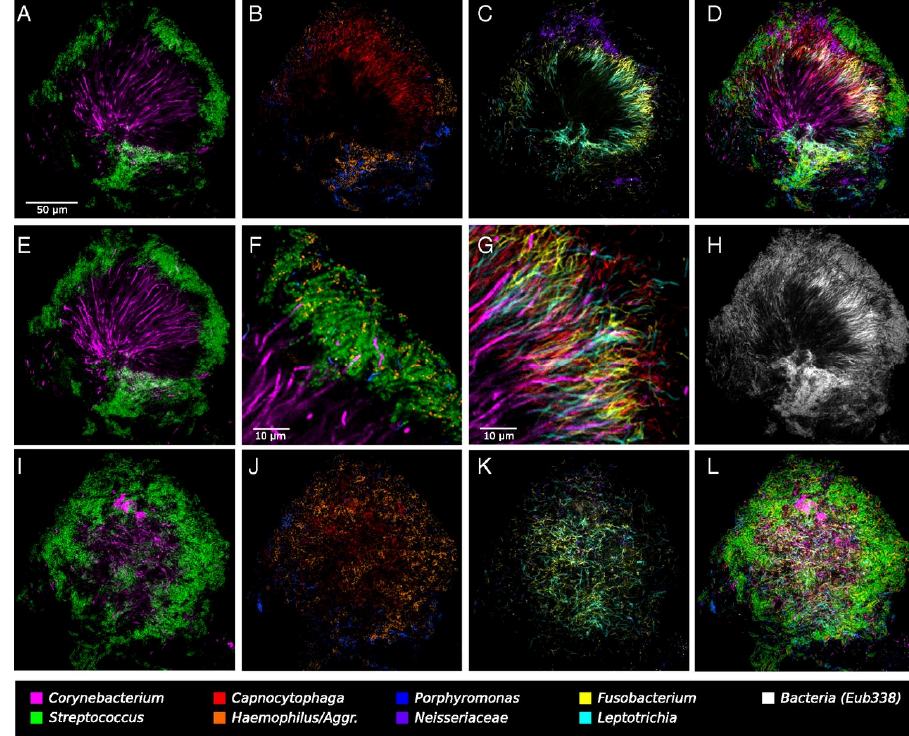
Figure 5. Hedgehog-shape structure. ( A – D , F – H ) represents a single focal plane nearby the middle part of the structure. ( A ) Corynebacterium sp. filaments radiating outward from near the center of the image and coccoid Streptococcus sp. cells arranged around the distal tips of the Corynebacterium sp. filaments. ( B ) Cells of Haemophilus/Aggregatibacter sp. and Porphyromonas sp. sited at the structure’s periphery, in the same region as the Streptococcus sp. cells. Capnocytophaga sp. also inhabited a wideband inside the periphery. ( C ) Fusobacterium sp. and Leptotrichia sp. occupying this band called “filament-rich halo”. Neisseriaceae establishing constellations in and nearby the periphery. Actinomyces sp. represented by a small number of cells located near the structure’s base. ( D ) All taxa overlayed. Many cells from the “filament-rich annulus” overlapped the exterior of the consortia. ( E – G ) Detail of the Corynebacterium ’s arrangement relatively to other taxa. ( E ) The maximum intensity projection of three adjacent optical sections shows that these filaments are continuous from the center to the periphery of the structure for more than 50 µ m. Some filaments persist visible within the Streptococcus sp. cells. ( F ) Detail of the periphery. Corncob structures are composed of a filamentous core (sometimes visualized as Corynebacterium filaments but often not stained) bordered primarily by Streptococcus sp. cells but also by Porphyromonas sp. and Haemophilus/Aggregatibacter sp., both in proximal contact with Streptococcus sp. cells. ( G ) On the periphery of these corncob structures, Corynebacterium sp. filaments pass through the halo that is highly densely colonized with elongated rods of Fusobacterium sp., Leptotrichia sp., and Capnocytophaga species. ( H ) The fluorescent signal of the universal probe EUB338. ( I – L ) The exterior of the hedgehog structure, composed mainly of corncobs. ( K ) The edge of the Fusobacterium - Leptotrichia sp. halo. Reprinted with the publisher’s